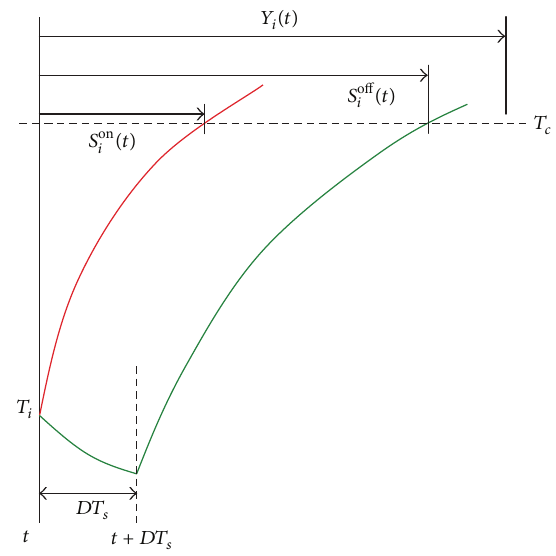
Figure 1: Predicted time intervals related to the decision